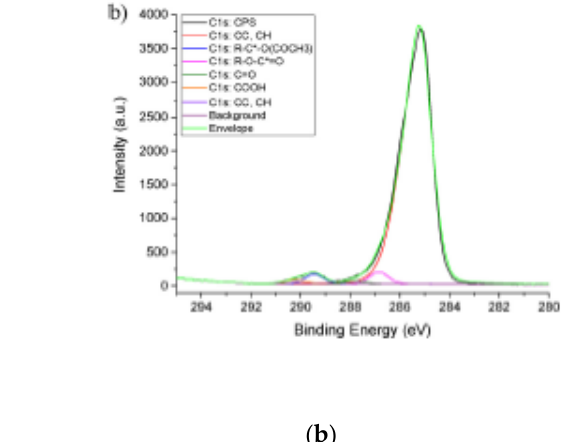
Figure 10. ( a ) C1s XPS spectra of EVA/EVOH/EVA film irradiated at different doses, ( b ) example of decomposition of the C1s spectrum recorded on sample irradiated at 270 kGy. Reproduced from [33] with the permission of Applied Surface Science.